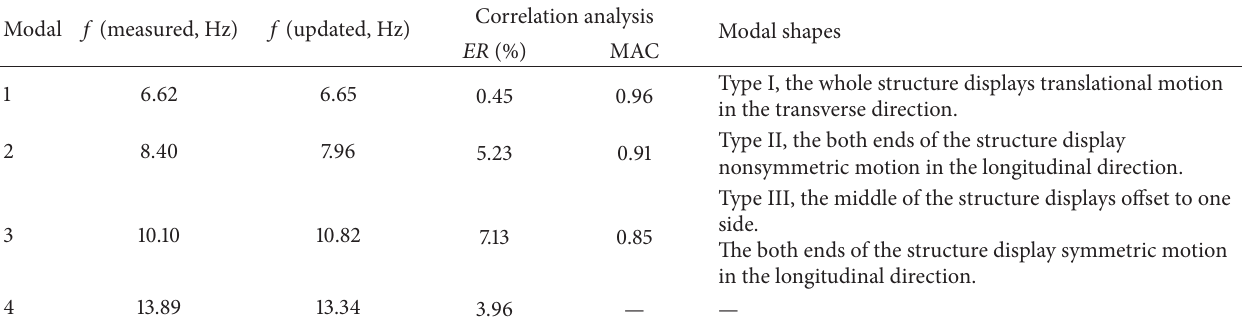
Table 4: Results of model